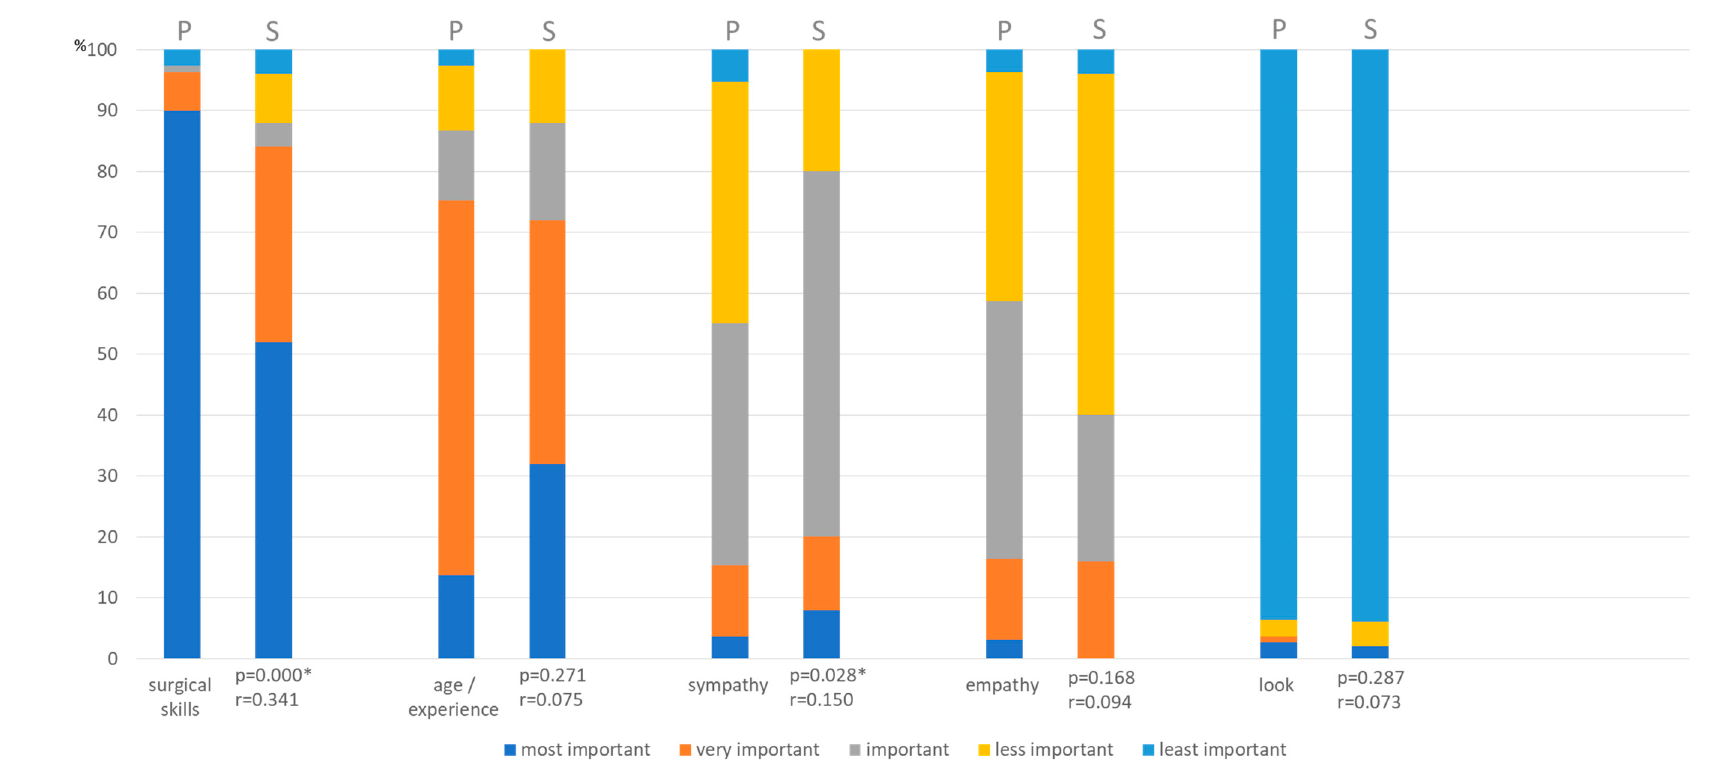
Figure 6. Opinion about most important factor for choosing surgeon (P = patients, S = surgeons). (* p ≤ 0.05).